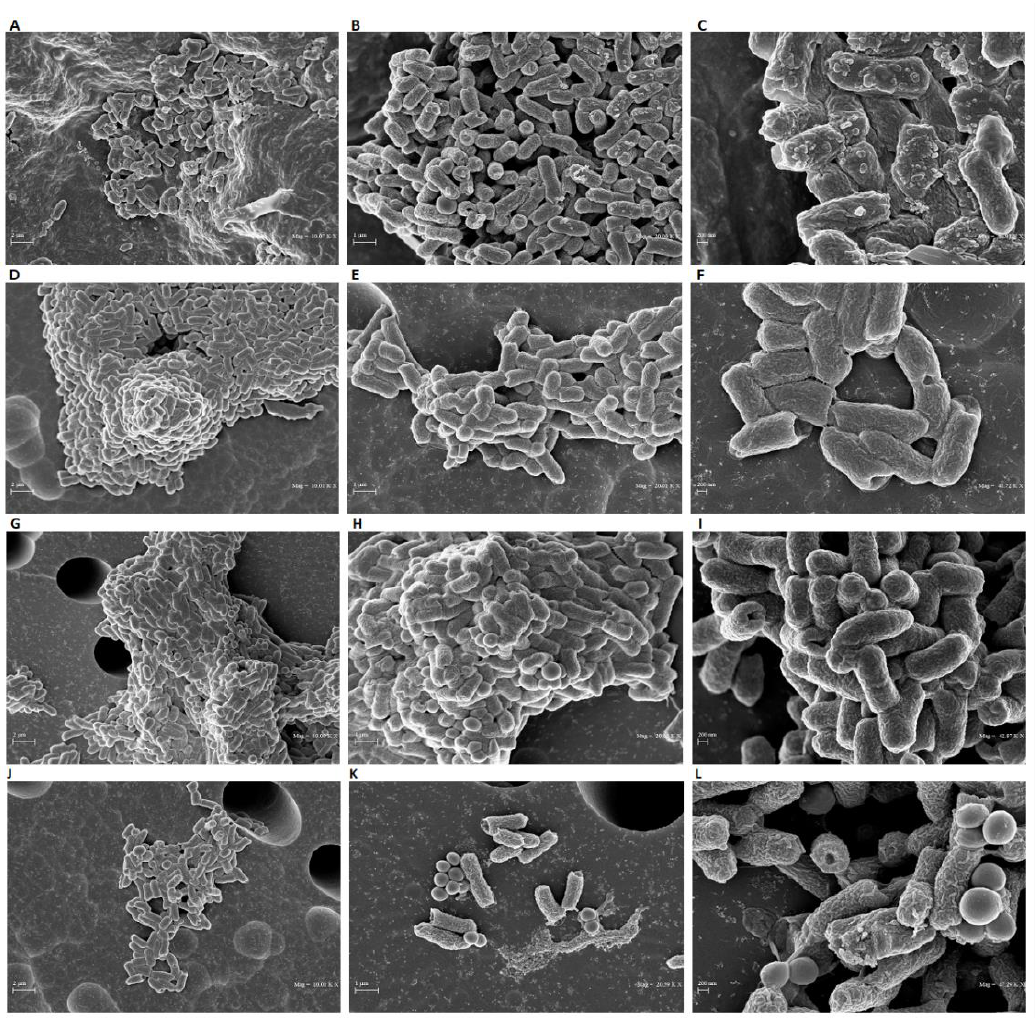
Figure 3. SEM analyses of C. striatum cells treated with niclosamide at 1 × MIC ( A – C ) and ½ × MIC ( D – F ). The negative CTRL was represented by bacteria treated with the solvent ( G – I ) and the posi- tive CTRL was represented by the treatment with vancomycin (5 μg/mL) ( J – L ). The treatment was carried out for 20 h at 37 °C. The images were obtained (from left to right) at 10,000×, 20,000×, and 40,000×